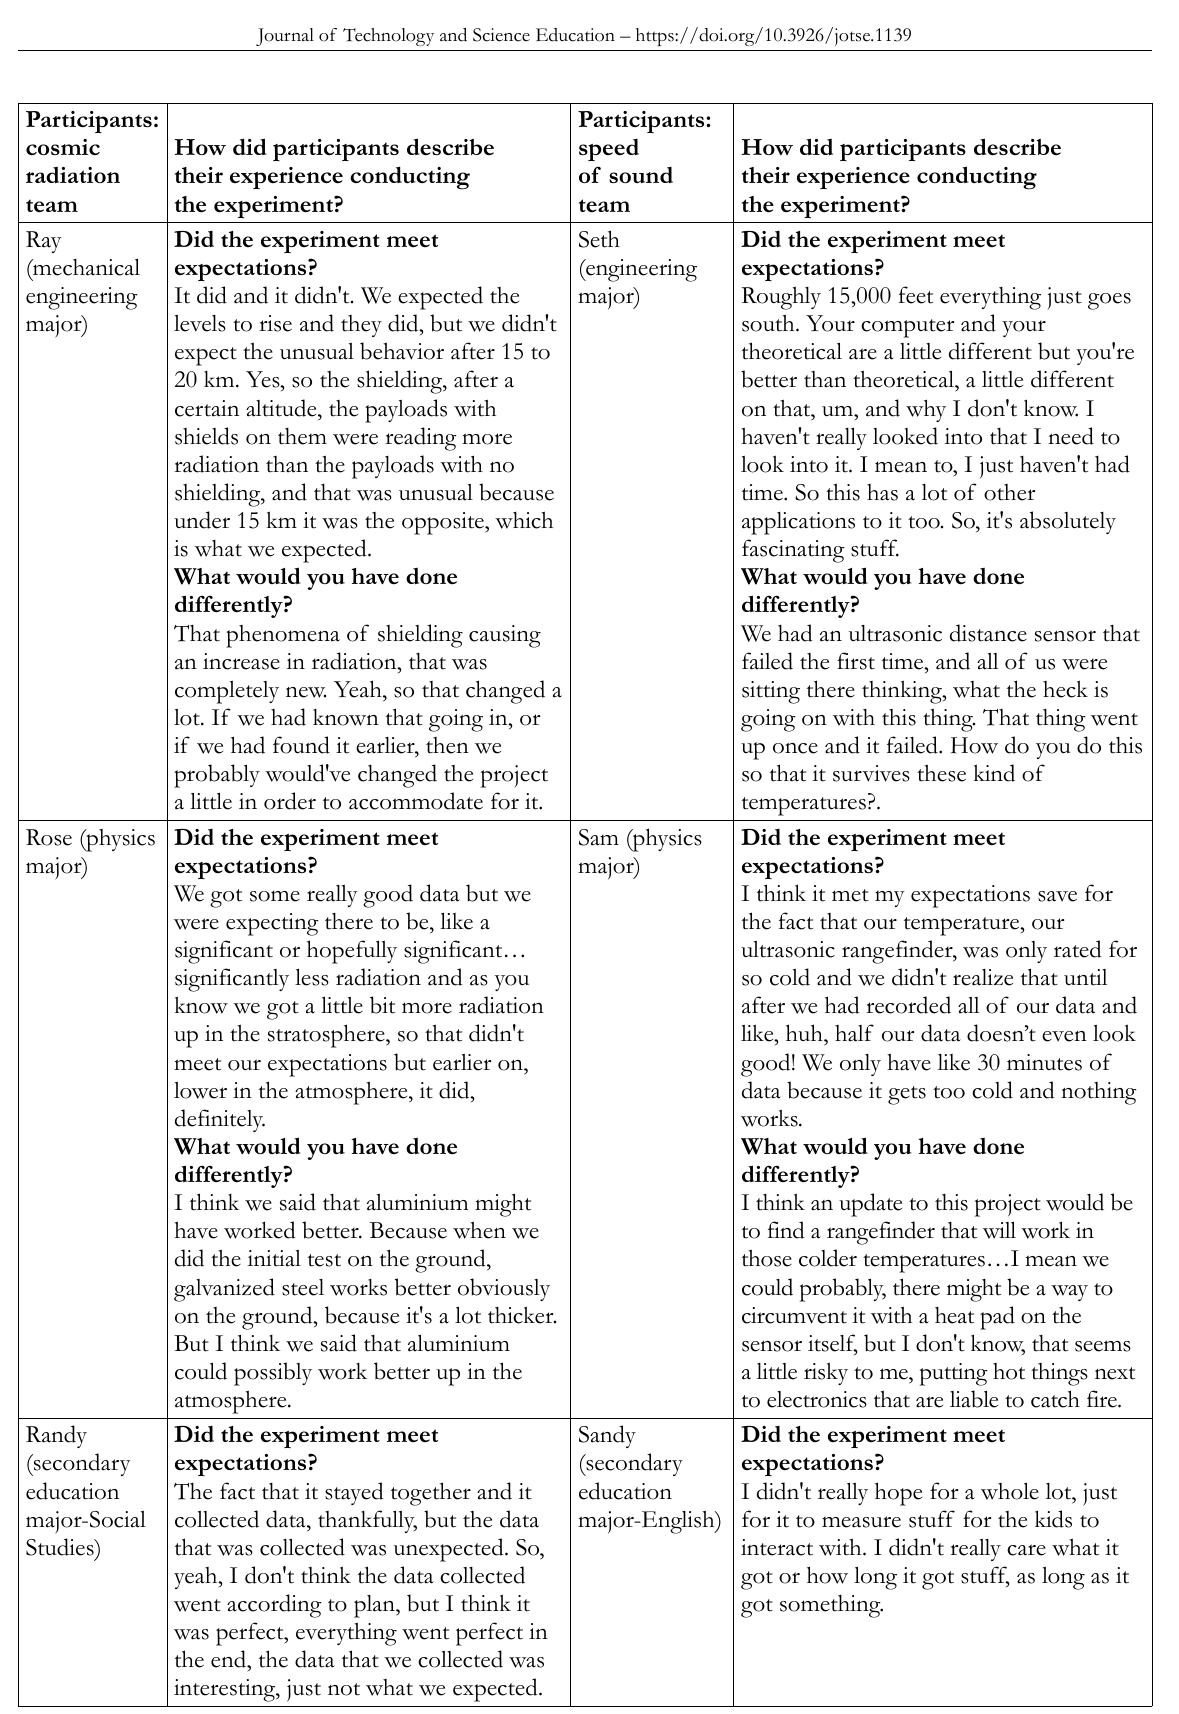
Table 5. Interview excerpts for each team regarding the experiment Both teams indicated surprising results that may have been addressed by refining their experimental payload and with subsequent balloon flight testing. The STEM majors offered specific ways to